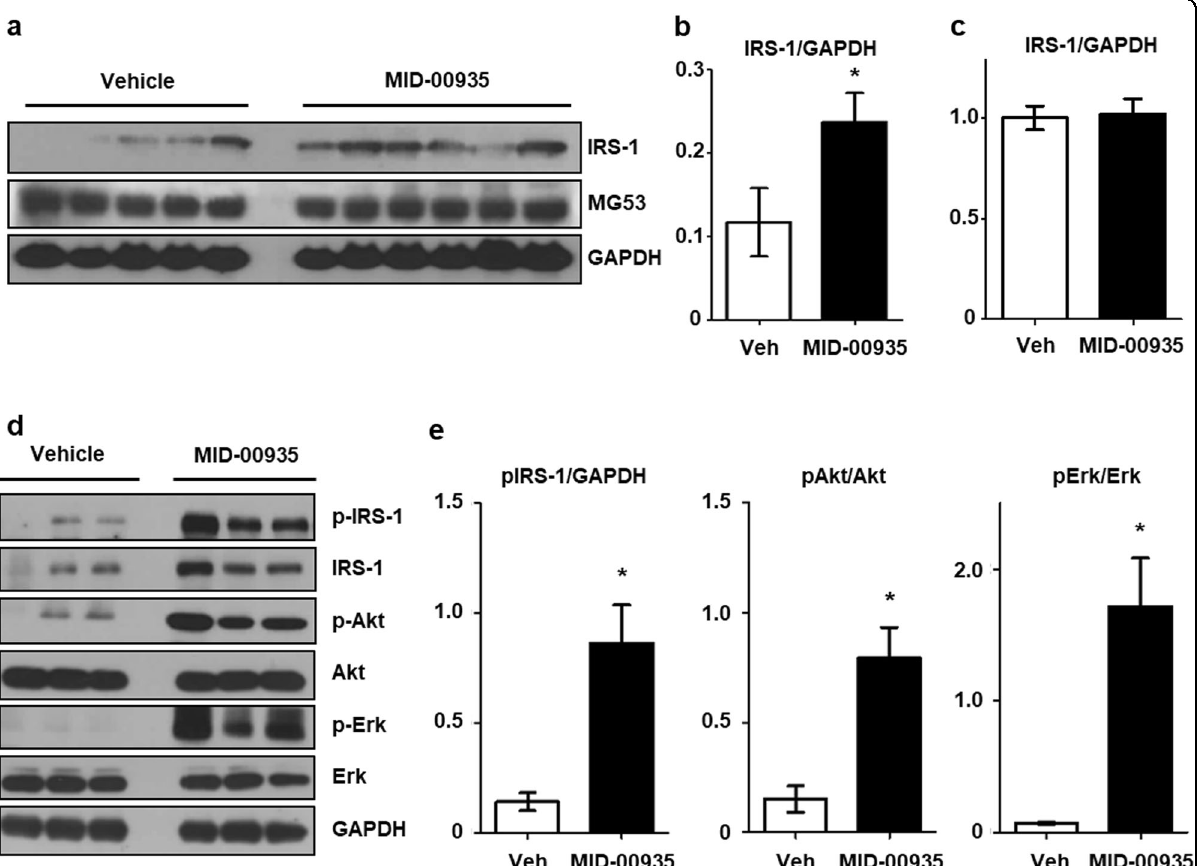
Fig. 5 MID-00935 improves insulin signaling in the skeletal muscle of DIO mice. Four-week-old male mice were fed a high-fat diet for 10 weeks and orally treated with vehicle or MID-00935 (100 mpk, twice a day) for 2 weeks. Soleus muscle was isolated from vehicle- and MID-00935-treated DIO mice. The protein levels of IRS-1 and MG53 were determined by immunoblotting ( a ). Increased IRS-1 levels were statistically assessed ( b ). The mRNA level of IRS-1 was determined by qPCR ( c ) ( n = 5 for the vehicle-treated group, and n = 6 for the MID-00935-treated group). Vehicle- or MID-00935- treated DIO mice were overnight-fasted, and soleus muscle was isolated at 10 min after an intraperitoneal insulin injection (10 U/kg of body weight). The expression levels of IRS-1, p-IRS-1, Akt, p-Akt, Erk, and p-Erk were determined by immunoblotting ( d ). p-IRS-1, p-Akt and p-Erk levels in the soleus muscle were statistically assessed ( n = 3 for each group) ( e ). Data are presented as the means ± SEM; * p < 0.05 compared to the